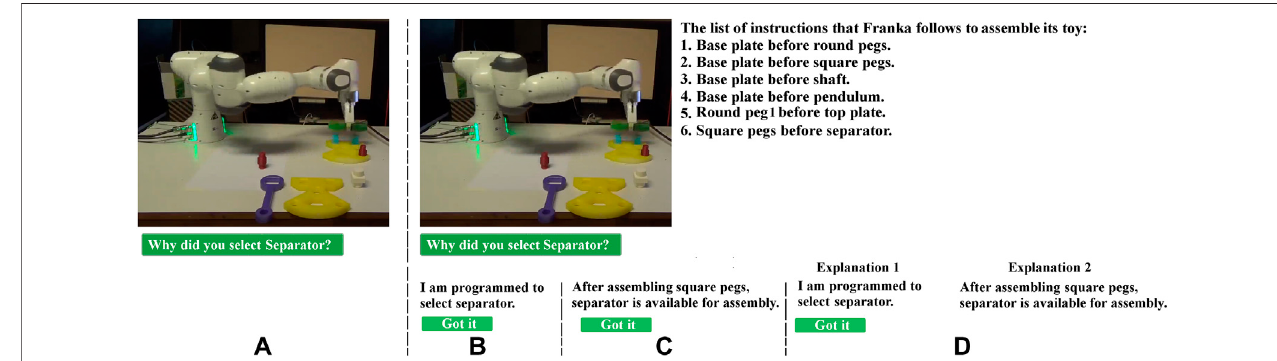
FIGURE2| Sub- fi gure (A) showsthedefaultinterface,whereparticipantscanwatchavideoshowingthecobotisassemblingCran fi eldbenchmark.Meanwhilethe button “ Whydidyouselectthisobject? ” alsoisshown,whichgivesparticipantsthechancetoreadthecobot ’ sexplanationaboutitsaction.Byclickingonthisbutton,the videostops,andbasedontheexperiment(between-subjectsorwithin-subjects)oneoftheotherthreesub- fi gures,i.e., (B – D) ,appears.Sub- fi gures (B,C) arerelatedto thebetween-subjectsdesignexperiment,sothatforhalfoftheparticipantsonly (B) isshown,andfortheotherhalfonly (C) isshown.Sub- fi gure (D) isshowninthe within-subjectsdesignexperiment, i.e., participants can seeexplanations generatedbythe baseline model and theproposedmodel at thesametime.Inany sub- fi gure, byclicking on “ Gotit ” button,theexplanation/sdisappears,and thevideocontinues(userscanagain asktherobot forexplainingitsnextactions byclicking on “ Whydid you select this object? “